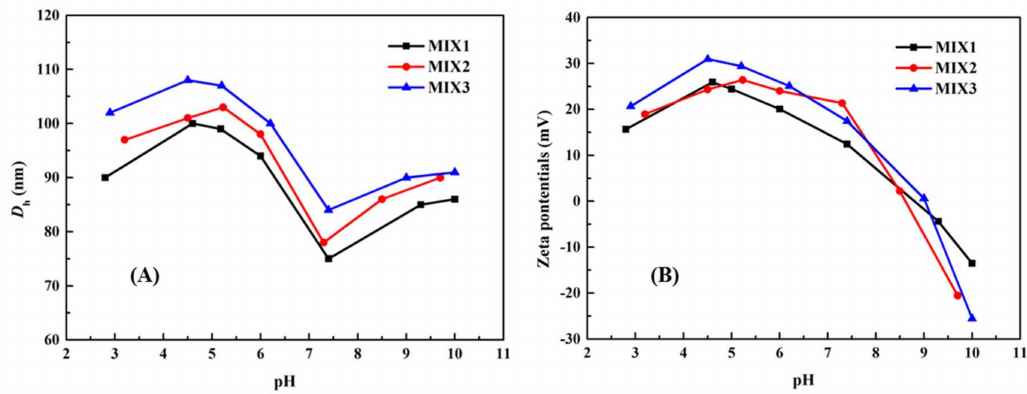
Figure 3. ( A ) Particle sizes and ( B ) zeta potentials of the polymeric mixed micelles dependence on pH values in aqueous